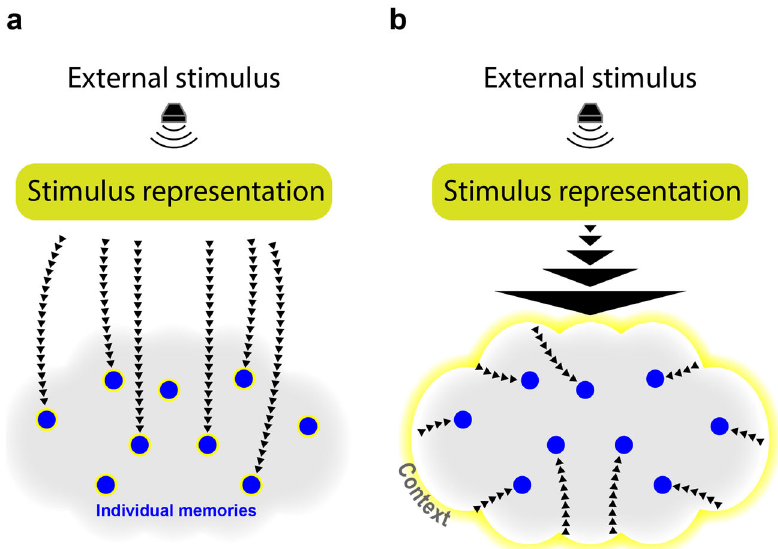
Fig. 5 Models explaining the behavioral results, supporting the parallel reactivation hypothesis. a In one model, individual memories are directly and simultaneously reactivated following stimulus presentation, regardless of the context in which they are embedded (e.g., locations of different cat images activated following a “ meow ” sound). Note that not all items in the context are reactivated (e.g., not all cat-related memories). b In contrast, in another model the stimulus reactivates a generalized context and its reactivation subsequently bene fi ts individual memories embedded in the